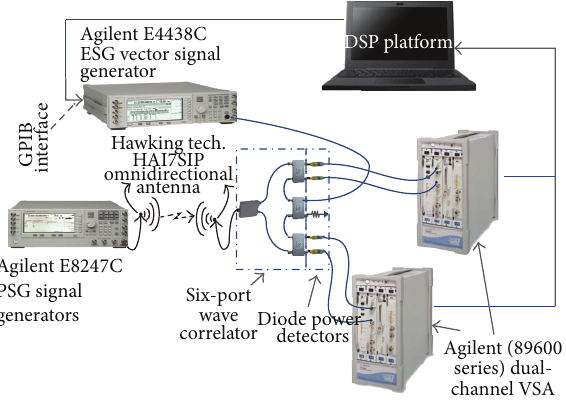
Figure 6: Test bench setup for the SPR Front-End using transmit- ting and receiving